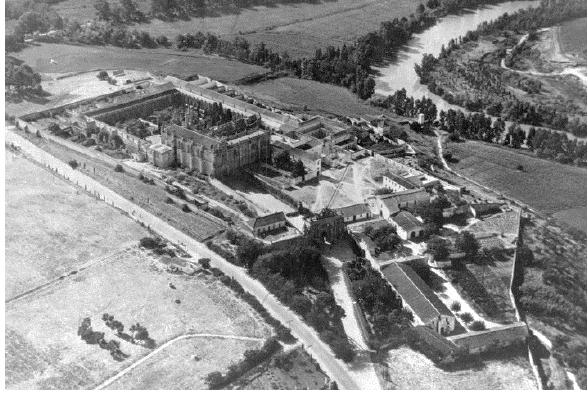
Figure 2: Charterhouse of Jerez. Aerial photography in the middle of the 20th century.